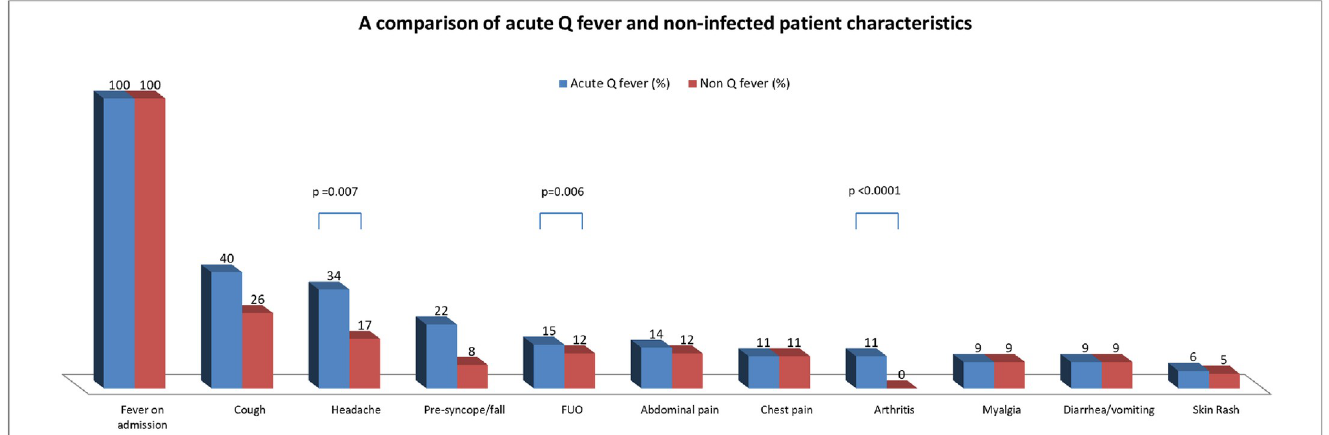
Fig 2. Bar graph demonstrating the percentage of patients in the acute Q fever versus non infected group with each clinical characteristic. In the case of a significant difference the p value is written above.